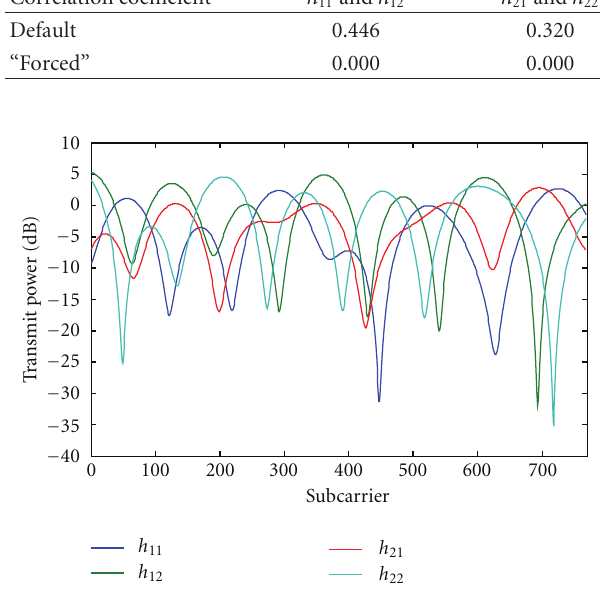
Figure 3: Channel gain at every spatial subchannel (uncorrelated